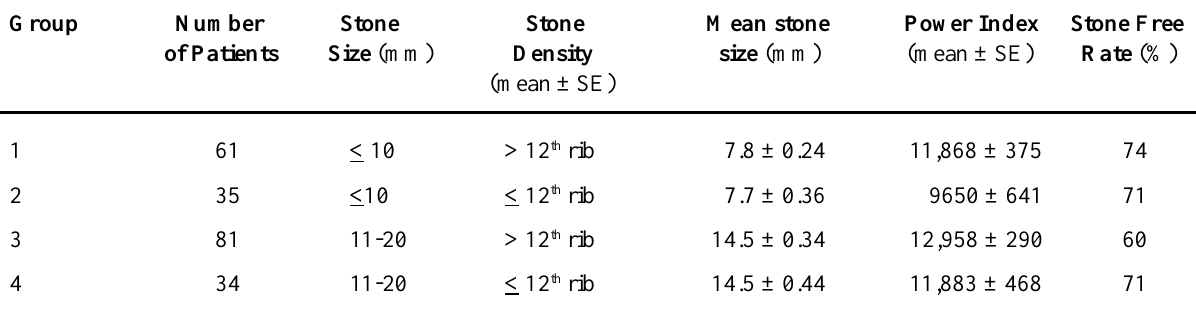
Table 1 – Outcome of shockwave lithotripsy based on stone size and stone radiodensity.